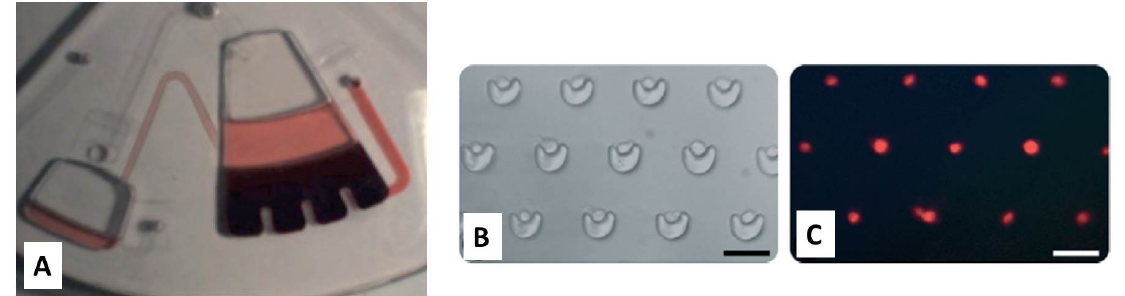
( A ) Blood plasma separation on a microfluidic disc from a large sample (>2 mL) of blood. Image reproduced from [85] with permission from Bioanalysis as agreed by Future Science Ltd. ( B ) Brightfield microscope image of individual HL60 cells captured in V-cup arrays; and ( C ) fluorescence imaging of the labeled cells. Scale bar = 50 µ m. Reproduced in part from [94] with permission of The Royal Society of